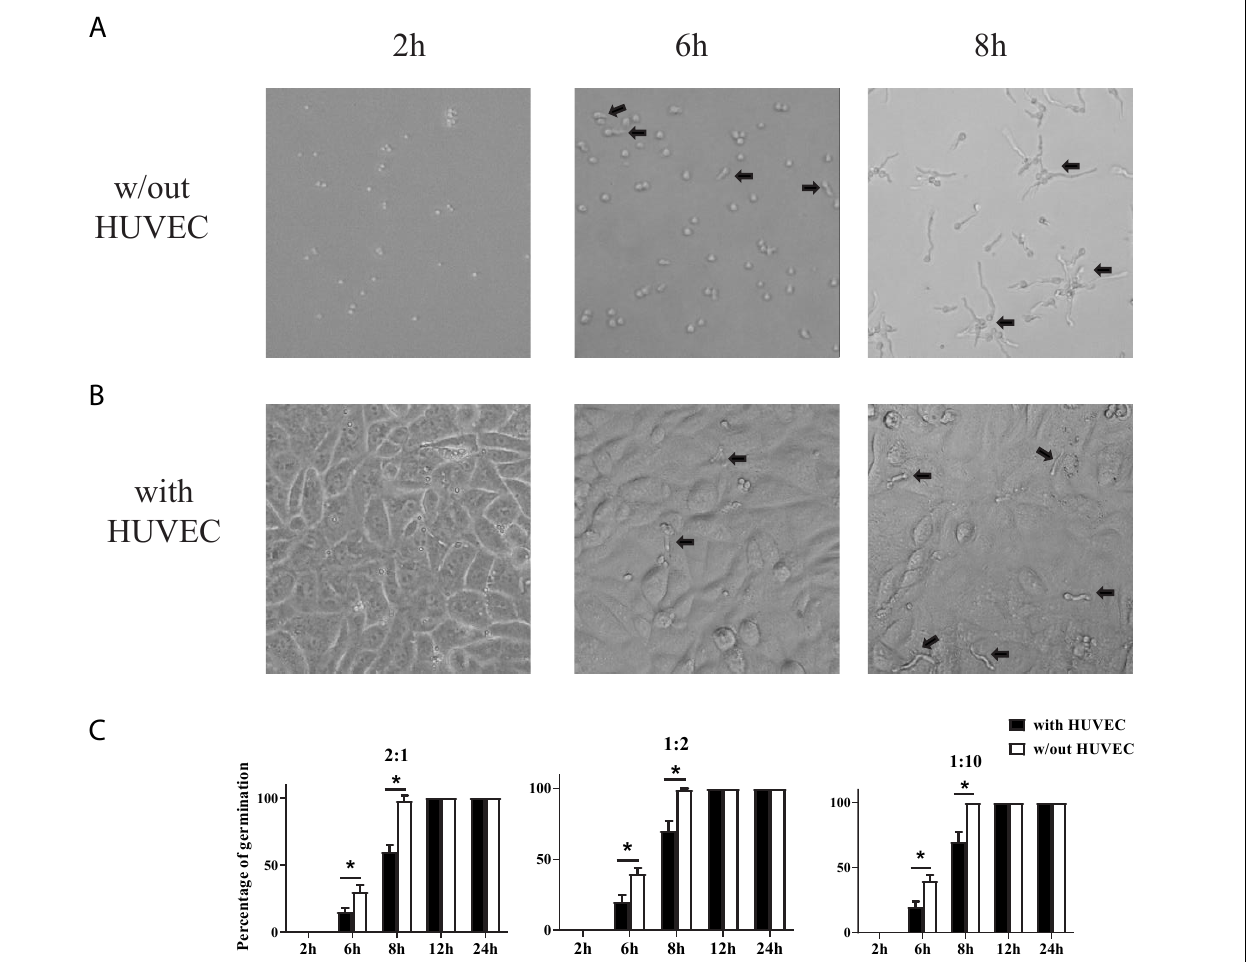
FIGURE 2 | Germination assay of conidia of A. fumigatus co-cultured with human umbilical vein endothelial cells (HUVECs). HUVECs were seeded in a 24-well plate (3 × 10 5 cells per well) overnight before the conidia of A. fumigatus were added to the wells at the indicated cell:spore ratio. Representative pictures of conidia at a 1:2 ratio taken at the indicated time with (A) or without (B) HUVECs. (C) The percentages of germinated conidia with added cell:spore ratio at indicated time points were calculated. * p < 0.05. Original magnification × 100. Black arrow: germinating